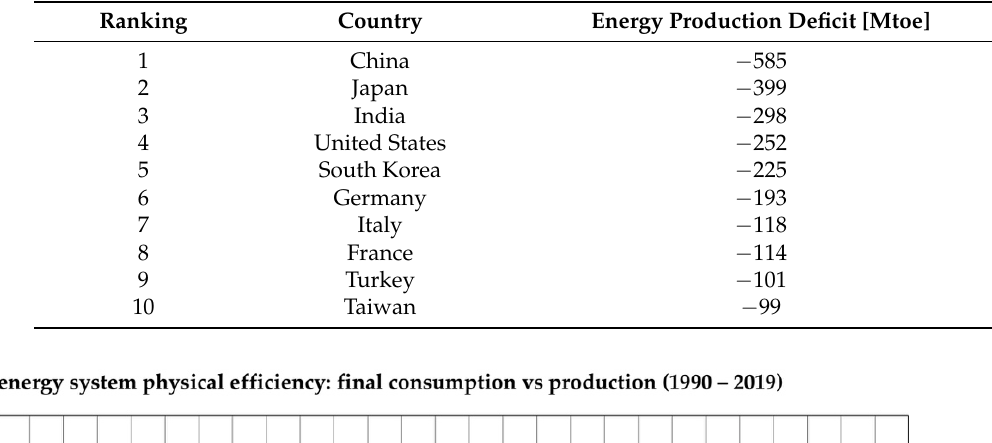
Table 6. Top-10 Countries (highest to lowest Mtoe values) for energy production deficit, obtained by the difference between energy production and consumption. Latest available data, expressed in Mtoe, refer to year 2016.